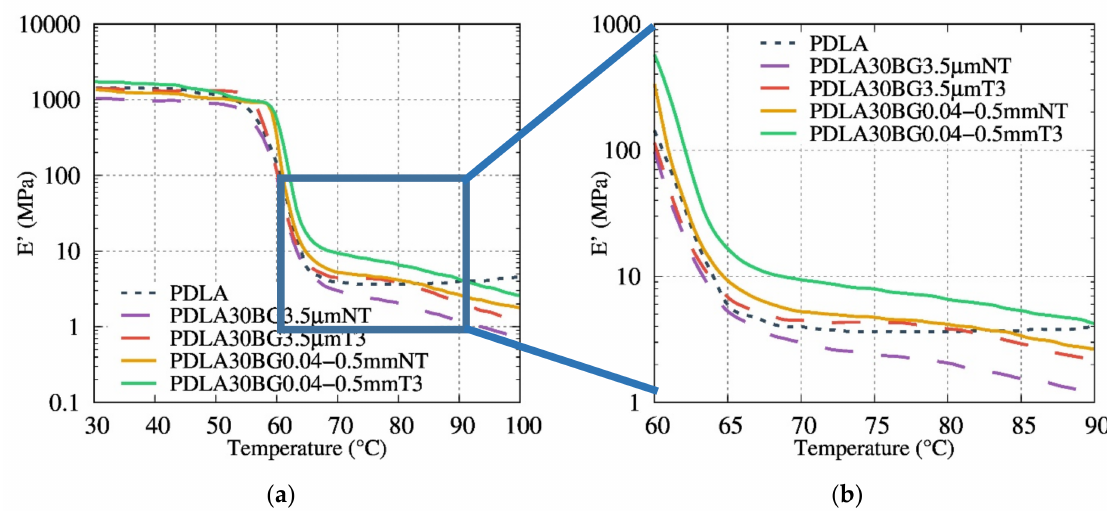
Figure 13. ( a ) Evolution of E’ (MPa) as a function of the temperature for composites filled with BG of various sizes and thermal treatment; ( b ) zoom of rubber plateau modulus.